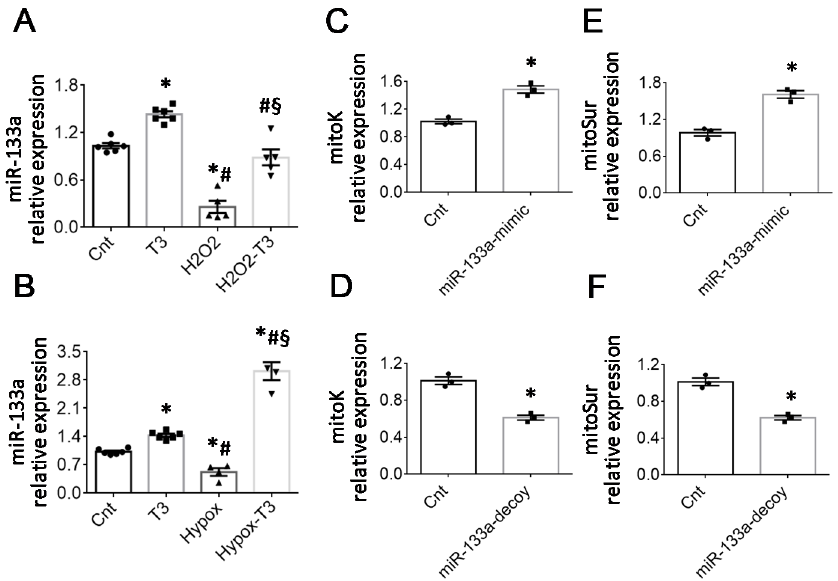
Figure 5. The T3-responsive miR-133a is involved in the up-regulation of mitoK and mitoSur. ( A , B ) Relative expression of miR-133a in the two in vitro models of oxidative and hypoxic stress. n ≥ 4, * p ≤ 0.03 vs. Cnt and T3; # p < 0.0001 vs. T3; § p < 0.0001 vs. Hypox or H 2 O 2 . ( C – F ) Relative expression of mitoK ( C , D ) and mitosur ( E , F ) in cultured neonatal cardiomyocytes 48 h post-transfection with miR-133a mimic or miR-133 decoy. n = 3 * p ≤ 0.001 vs. the respective Cnt.